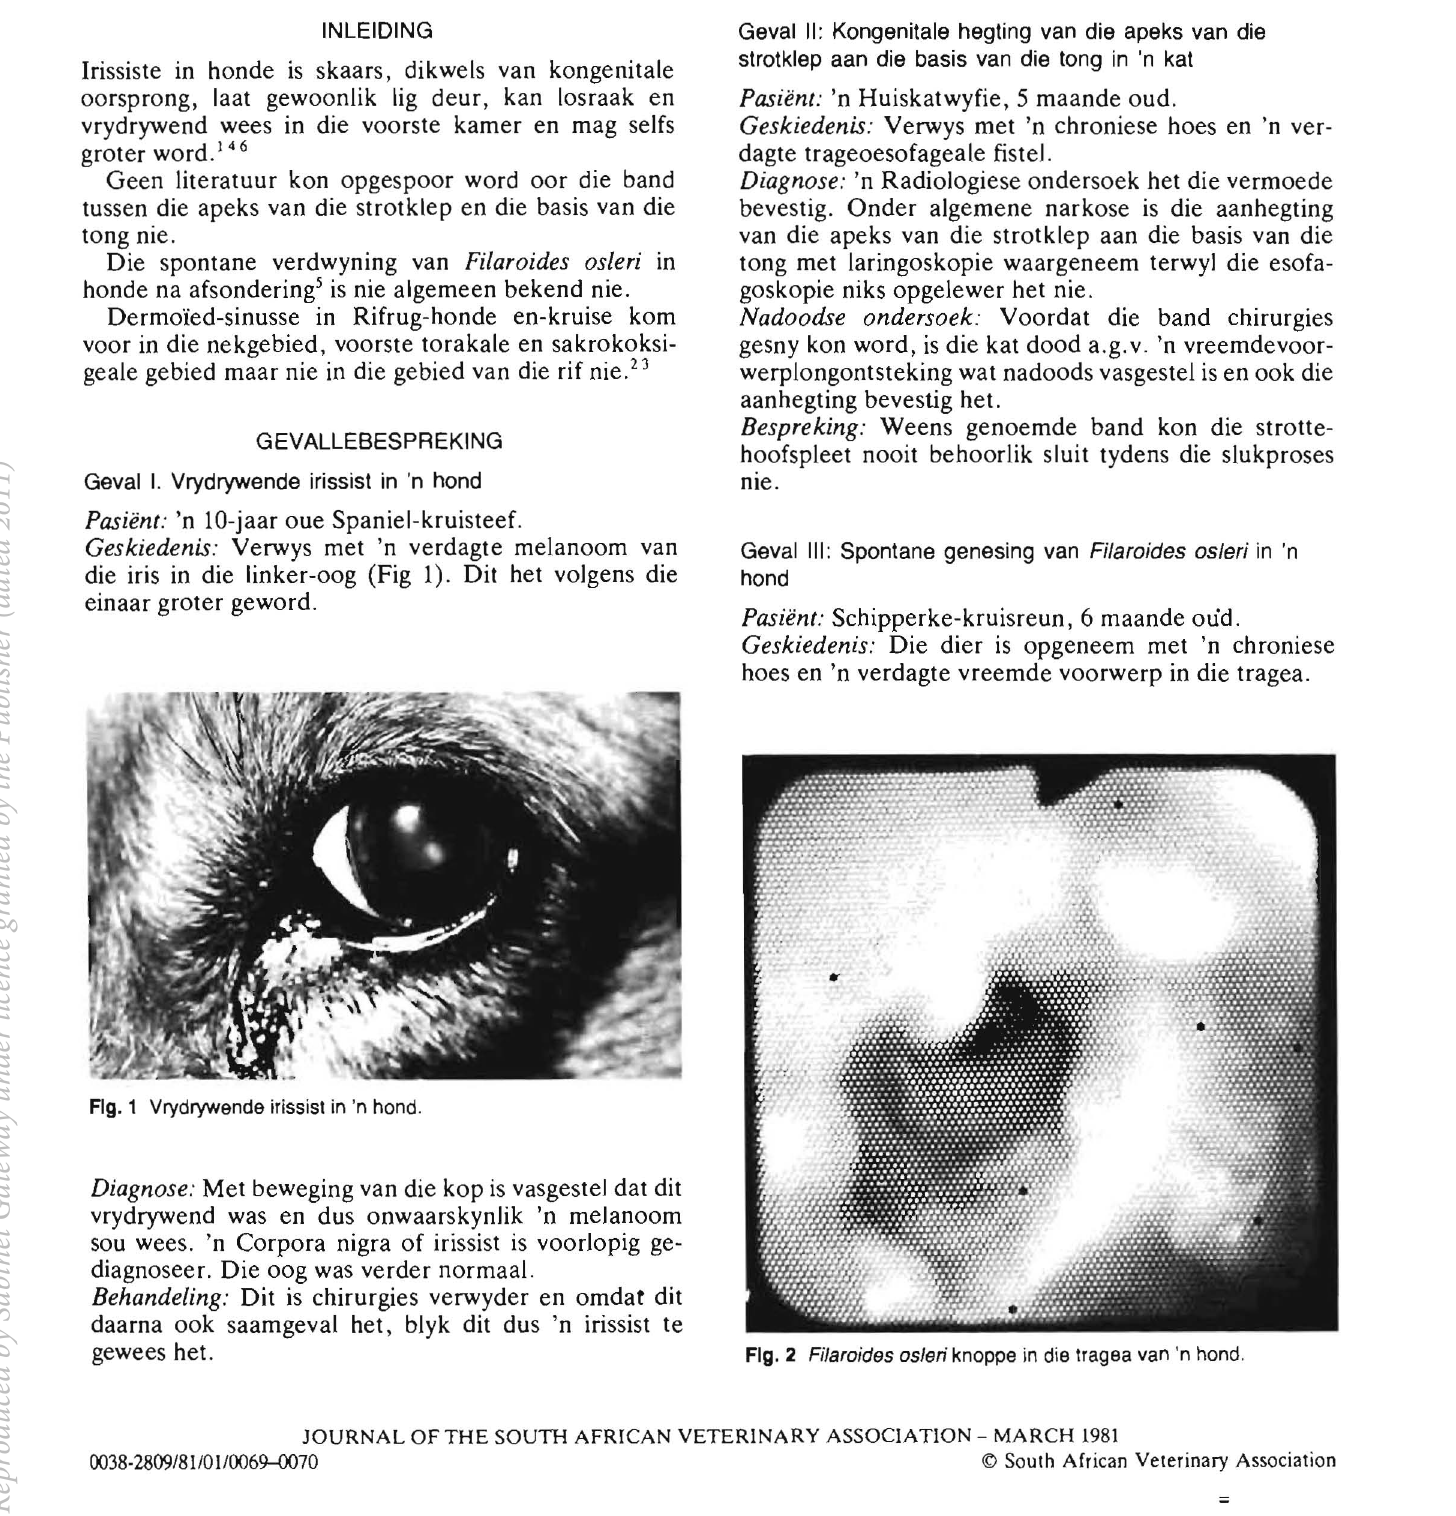
FIg. 1 Vrydrywende irissist in 'n hondo